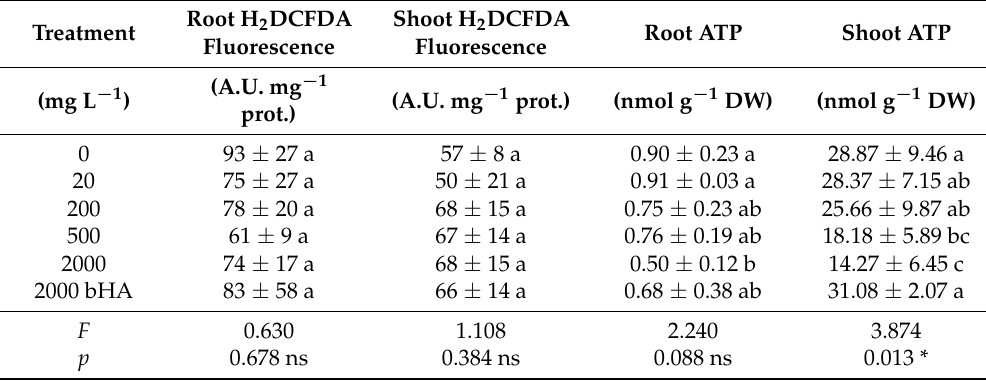
Table 3. One-way ANOVA analysis performed on reactive oxygen species (ROS) and ATP content measured in S. lycopersicum seedlings to evaluate the effect of different concentrations of CMC- n HA and bHA.